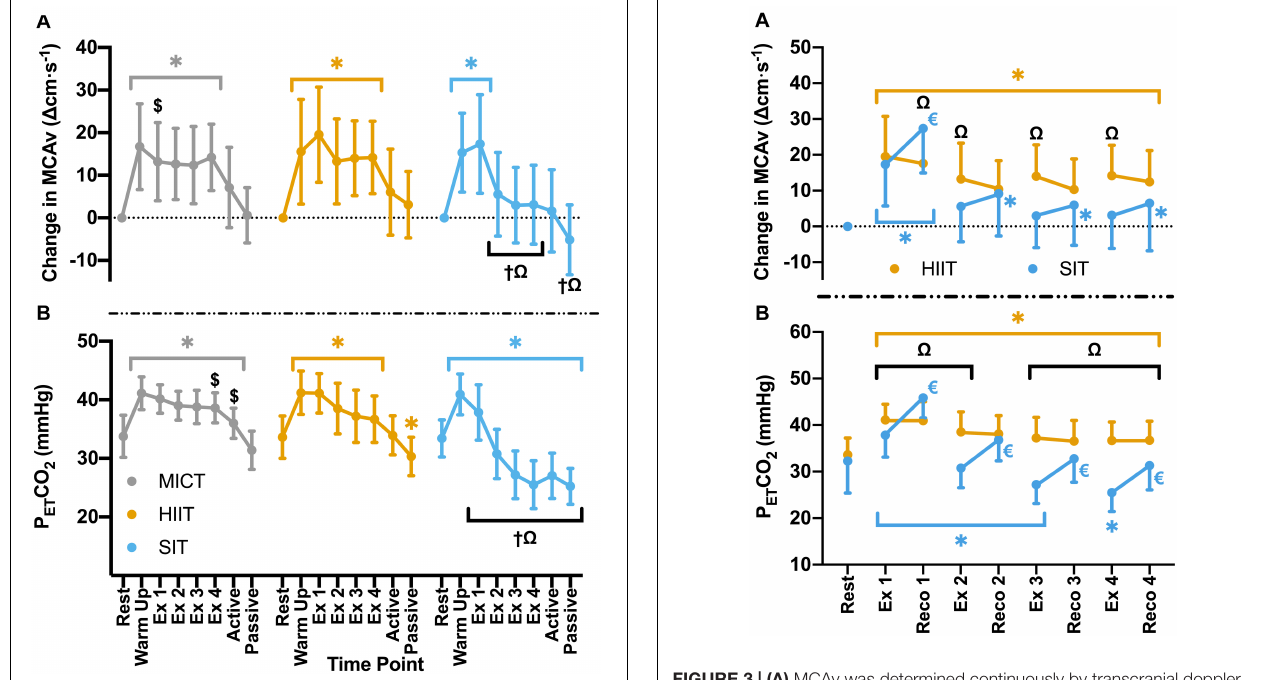
FIGURE 2 | (A) MCAv was determined continuously by transcranial doppler ultrasound (TCD) and presented as change in MCAv from rest in each protocol for each participant. (B) P ET CO 2 was determined through breath-by-breath respiratory gas exchange and ventilation. Data were averaged over 30 s of rest (rest); 5 min warm up (warm up); 3 min active recovery (active); and 15 min seated passive recovery (passive) in all protocols. Exercising averages (Ex